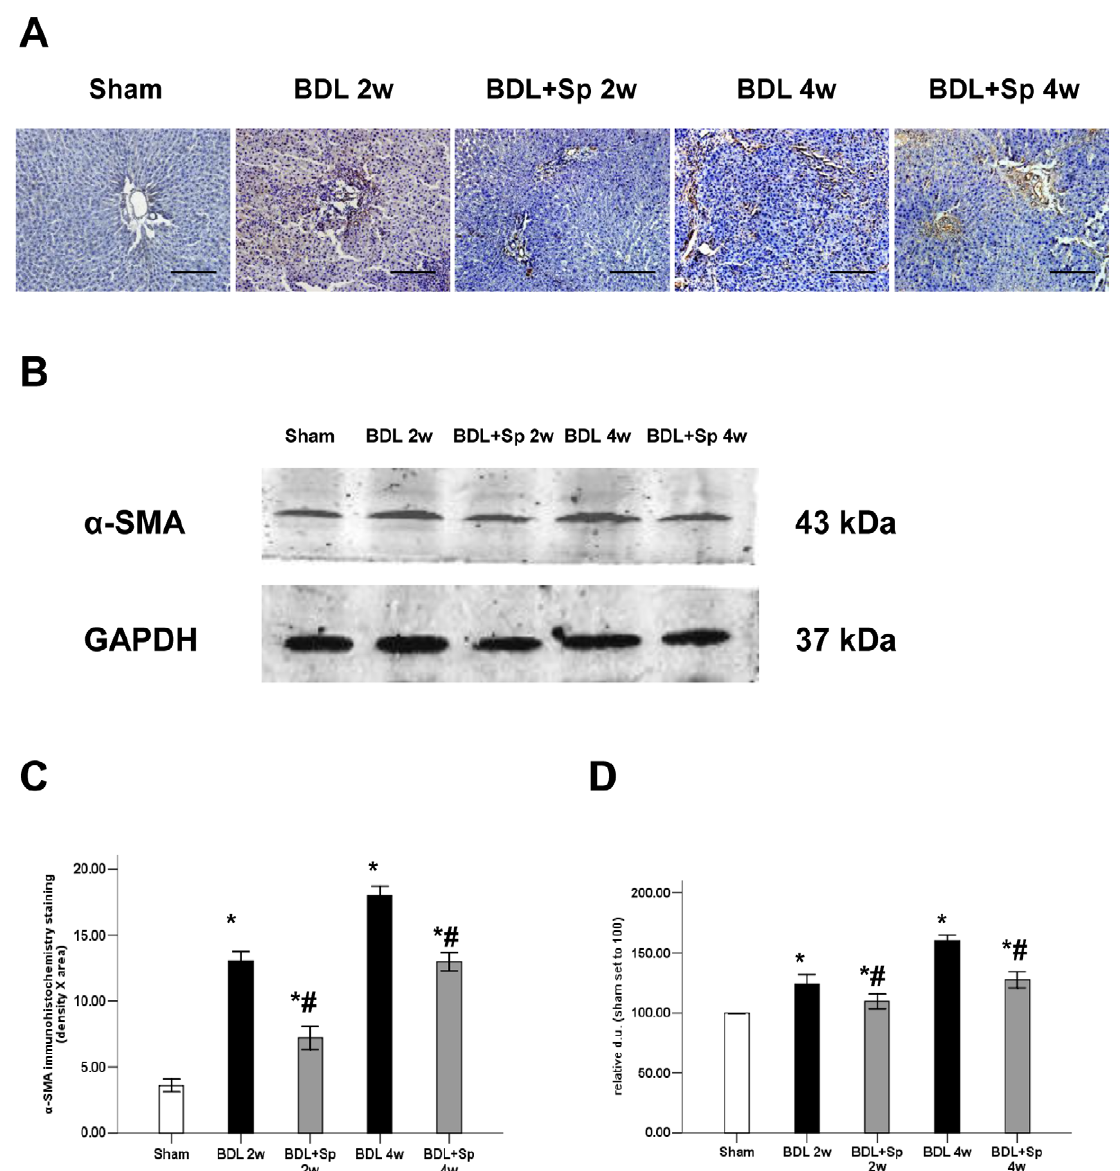
Figure 3. Effects of therapeutic treatment with Sprionolactone (Sp) on hepatic HSCs accumulation, assessed by (A) immunohistochemistry for hepatic a -smooth muscle actin ( a -SMA) (magnification 200 6 ) and (B) Western blot analysis of a -SMA expression. Semiquantitative measurement of immunohistochemistry (C) and Western blot analysis (D) for a -SMA. * p , 0.05 compared to the Sham group. # p , 0.05 compared to the BDL